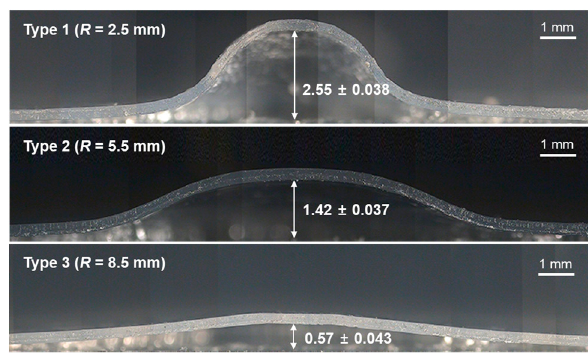
Figure 5. Sectional photographs of the formed film after ultrasonic stretching using various horn types with different tip radii (unit: mm).